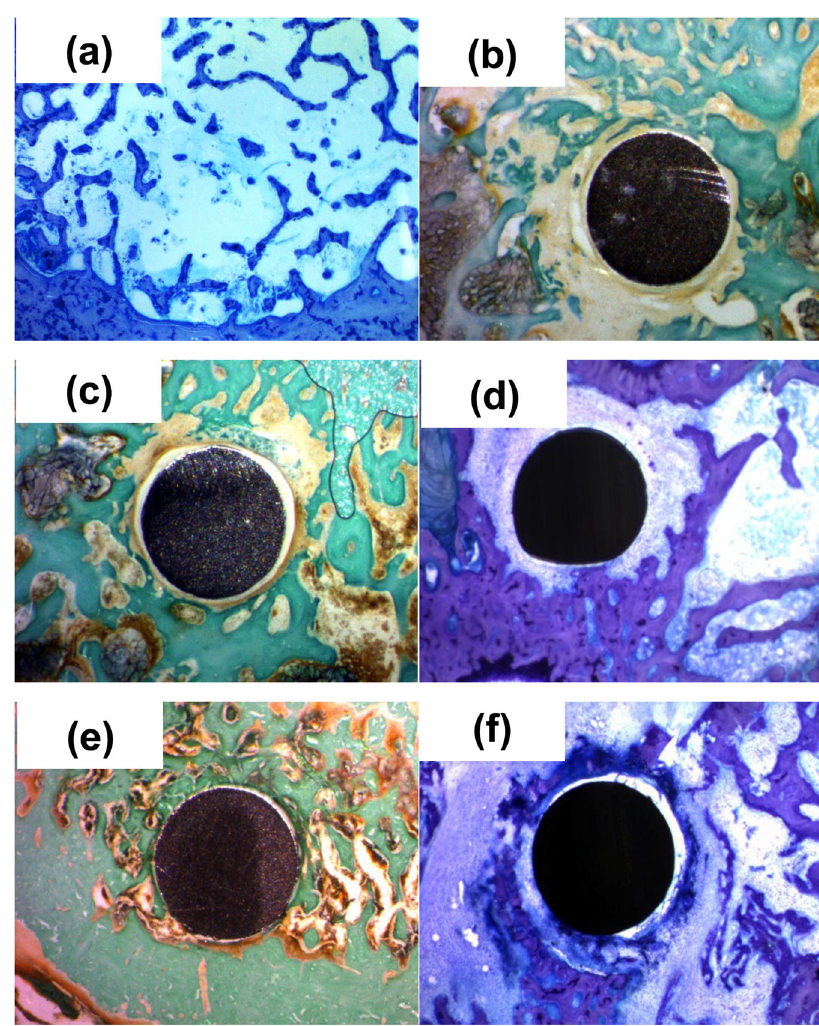
Fig. 2 Histology after 15 days of implantation for: a control femur b Ti6Al4V as received, c